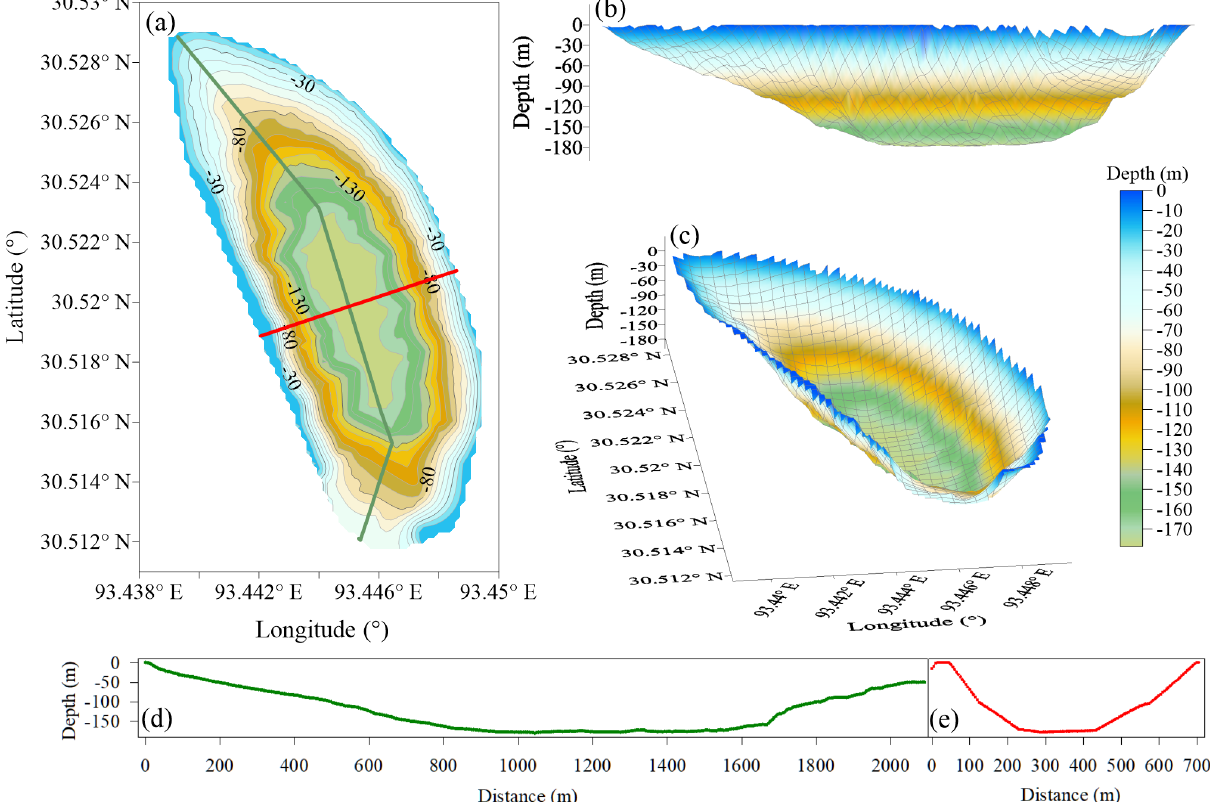
Figure 4. Morphology modeling of Bienong Co in 2020, as well as equal-scale profiles of distance and depth from the moraine dam to Mulang Glacier (green line) and from the left shore to right shore (red line).